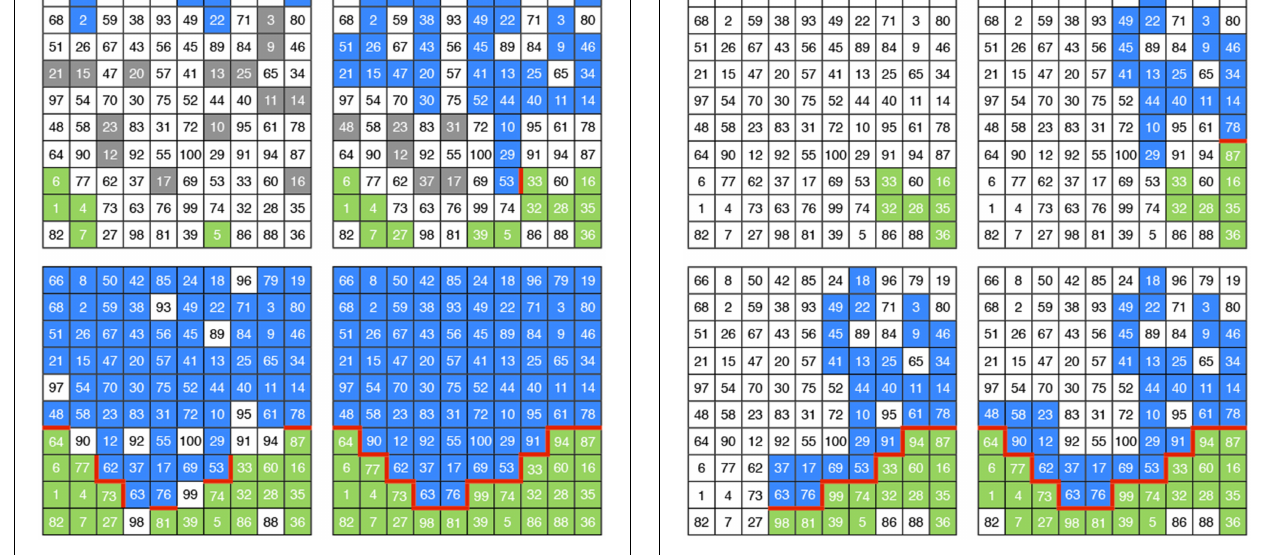
FIGURE 3 | Flooding algorithm to determine the watershed. Two sinks are considered: the top row and the bottom one. Cells in the discretized map are occupied following the rank, from the lowest to the highest. Neighboring occupied cells are considered connected and part of the same basin (gray cells). The basins connected to the top row (blue) correspond to the ones draining toward the top sink. Similarly, the ones connected to the bottom row (green) drain toward the bottom sink (upper-left panel). If two neighbors of the next cell in the rank belong to basins of different sinks, the edges in contact with the cells are marked as elements of the watershed (red-thick edges). The process proceeds iteratively until all cells are flooded (bottom panels). At the end (bottom-right panel), the watershed splits the discretized map into two basins (blue and green).